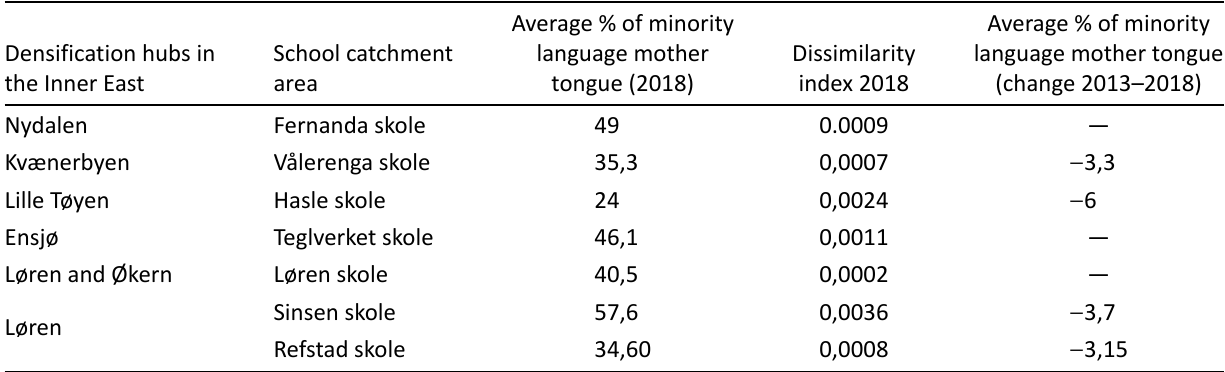
Table 2. School Composition and Densification Hubs in the Inner